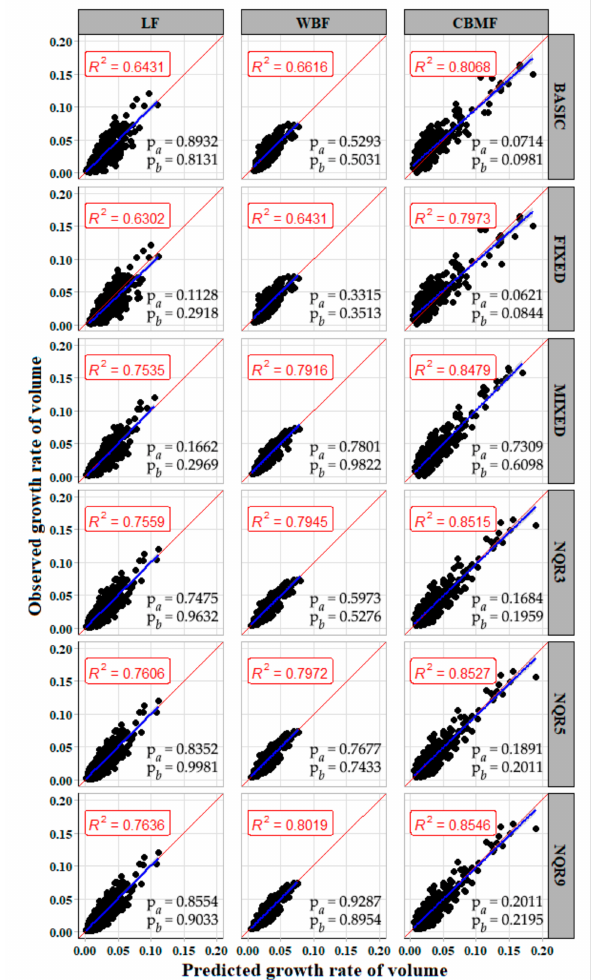
Figure 6. Plot for the observed and predicted RGR nv of the BASIC, FIXED, MIXED, NQR3, NQR5, and NQR9 models. Table 5. Testing of contrasts of sample plots with the result of NQR9 for LF, WBF, and CBMF. A bold, underlined number denotes a significant difference ( p < 0.05) in the test of contrasts.